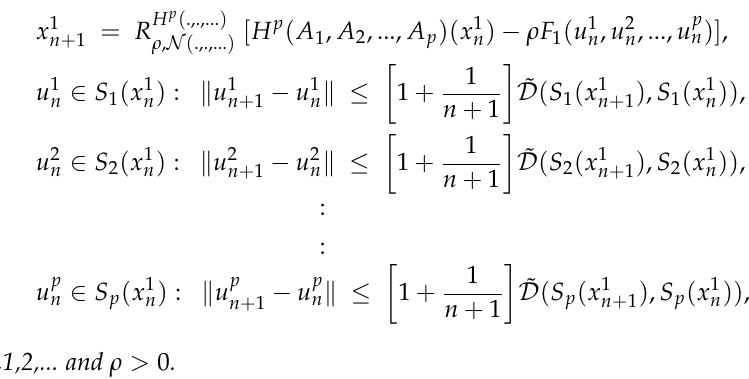
∈ Y, we select u 1 0